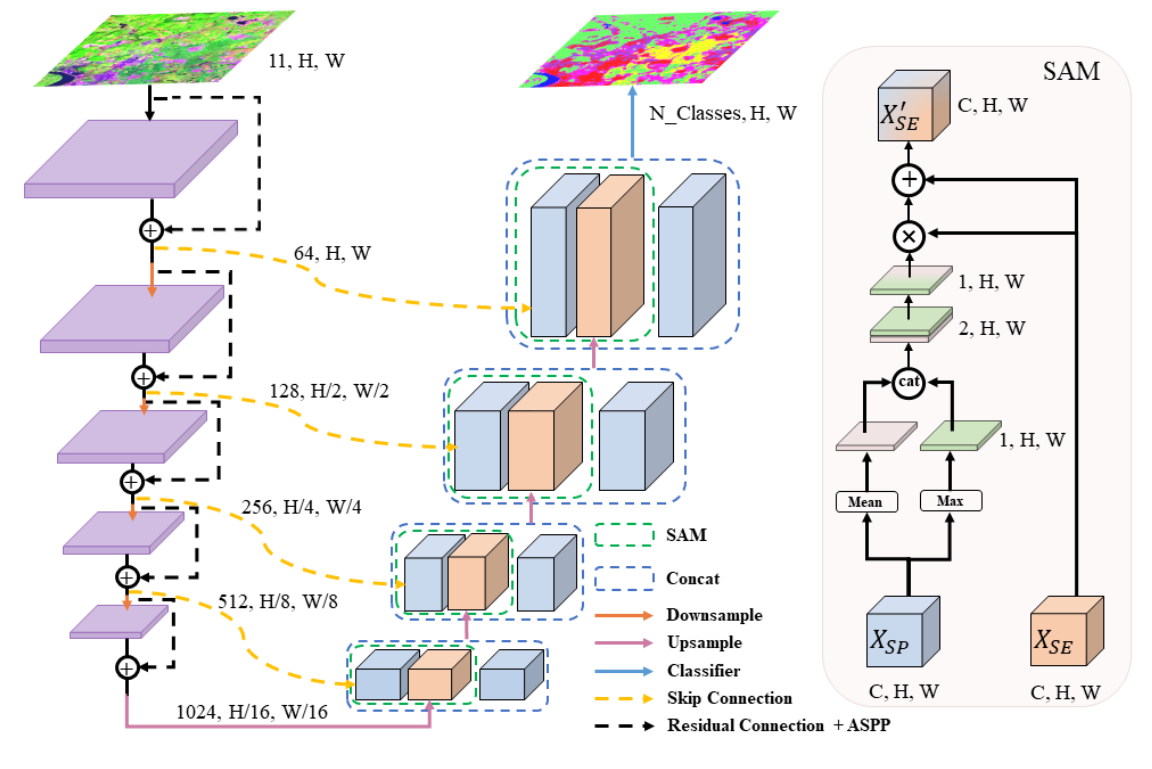
Figure 6. SA-UNet structure.